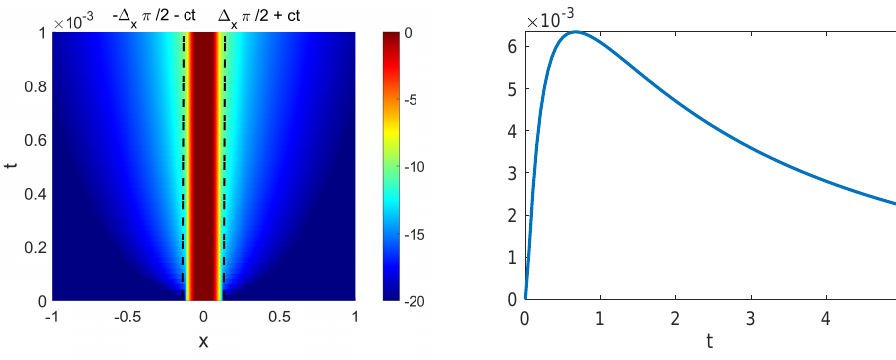
(cid:12) (cid:12) 2 (cid:12) (cid:12) ( t , x ) ] for the function with initial compact support (cid:12) ψ f (cid:12)